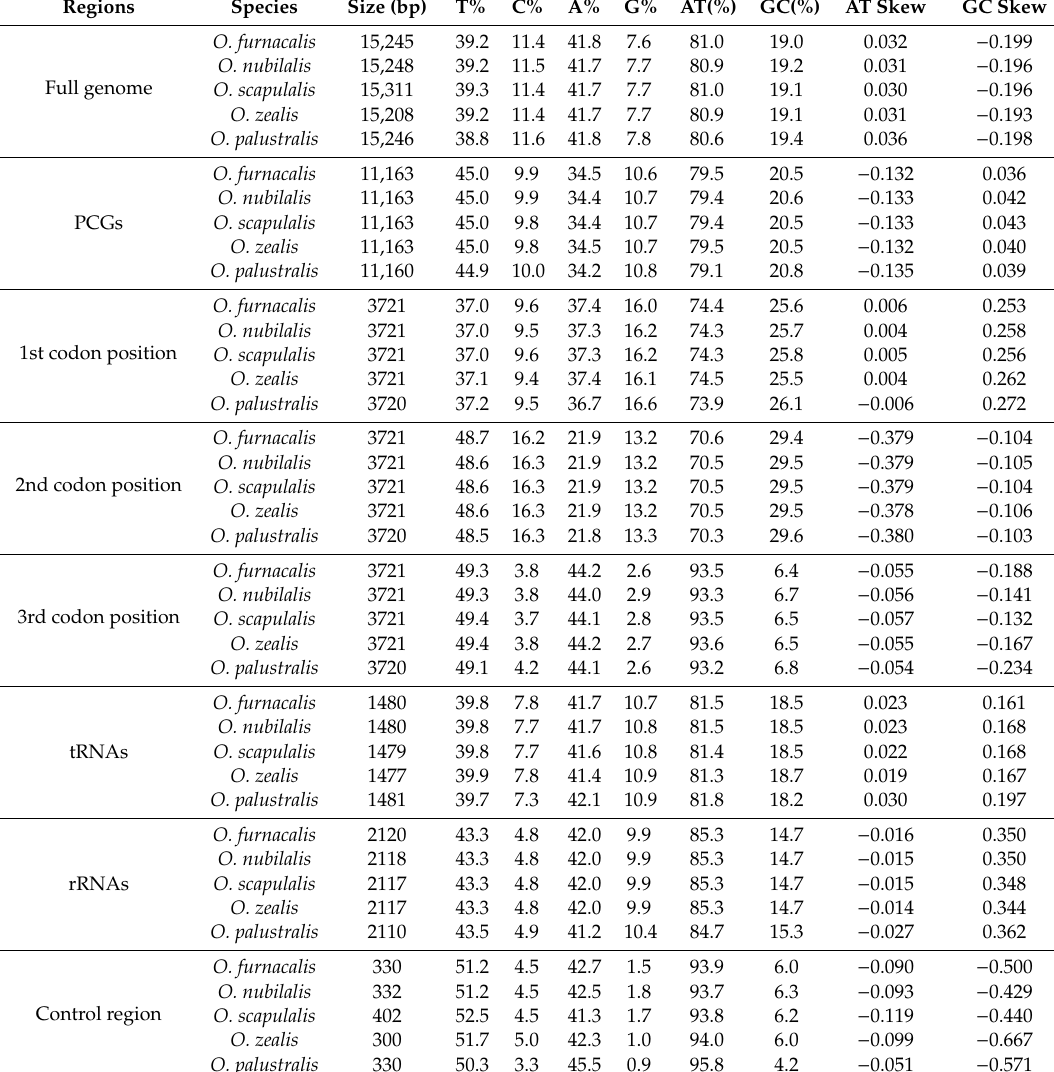
Table 2. Nucleotide composition and skewness of five Ostrinia spp. mitogenomes.